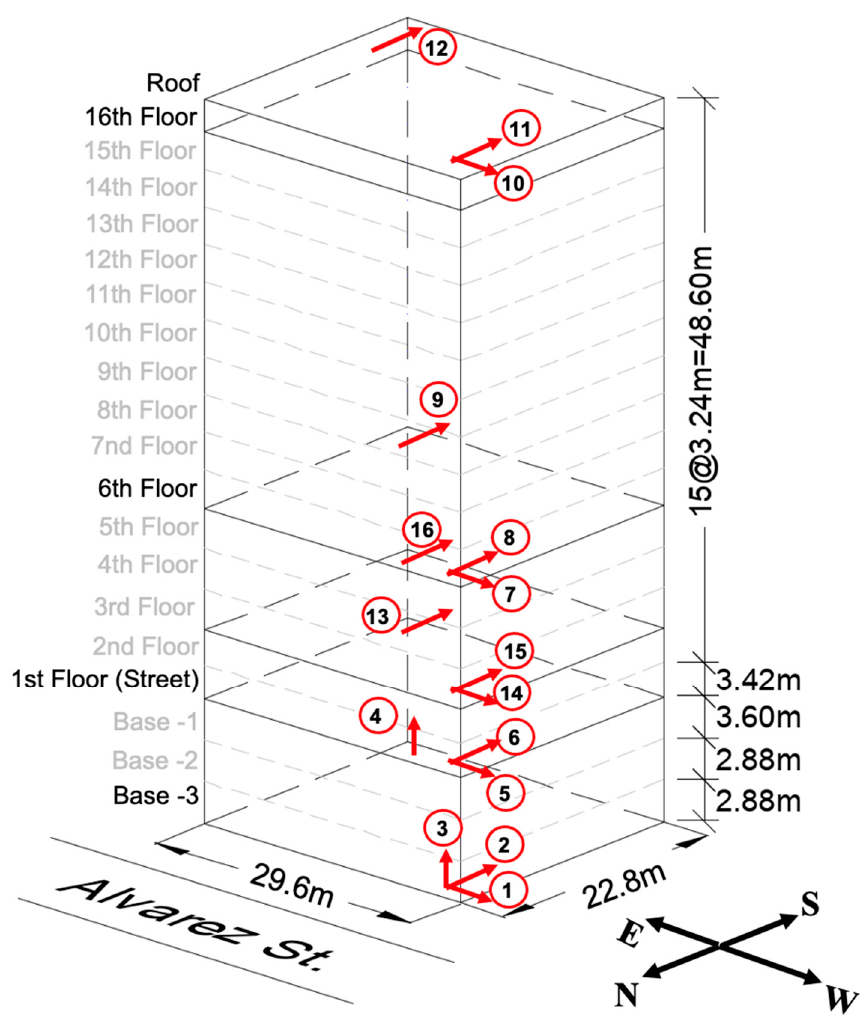
Figure 2. Arrangement of temporary deployment of sensors in the building.